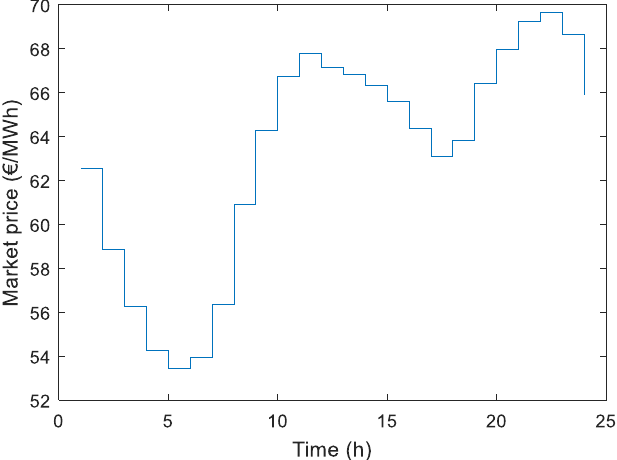
Figure 3. Spanish market yearly-average clearing price.